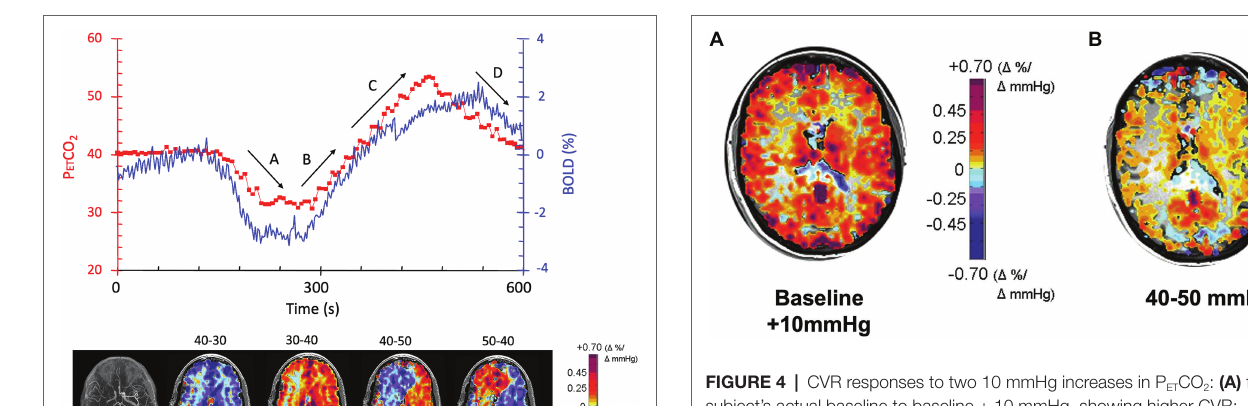
FIGURE 4 | CVR responses to two 10 mmHg increases in P ET CO 2 : (A) from subject’s actual baseline to baseline + 10 mmHg, showing higher CVR; (B) from 40 to 50 mmHg, showing that CVR is globally reduced. Subject was a healthy active 30-year-old female with resting P ET CO 2 ranging between 28 and 30 mmHg on different days, verified by a direct measure of PaCO 2 ; her commensurately reduced bicarbonate level indicated that this was a longstanding condition, not due to acute